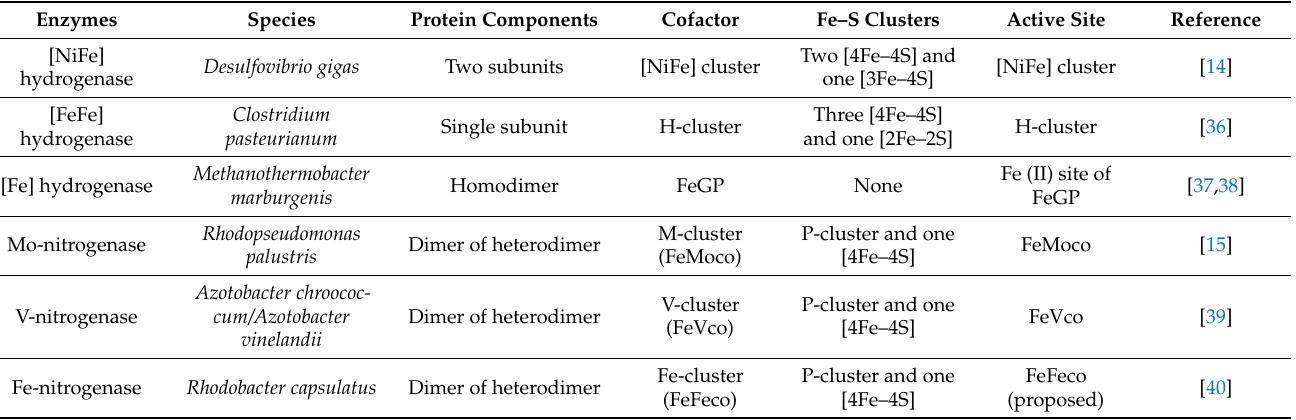
Table 1. Different types of hydrogenases and